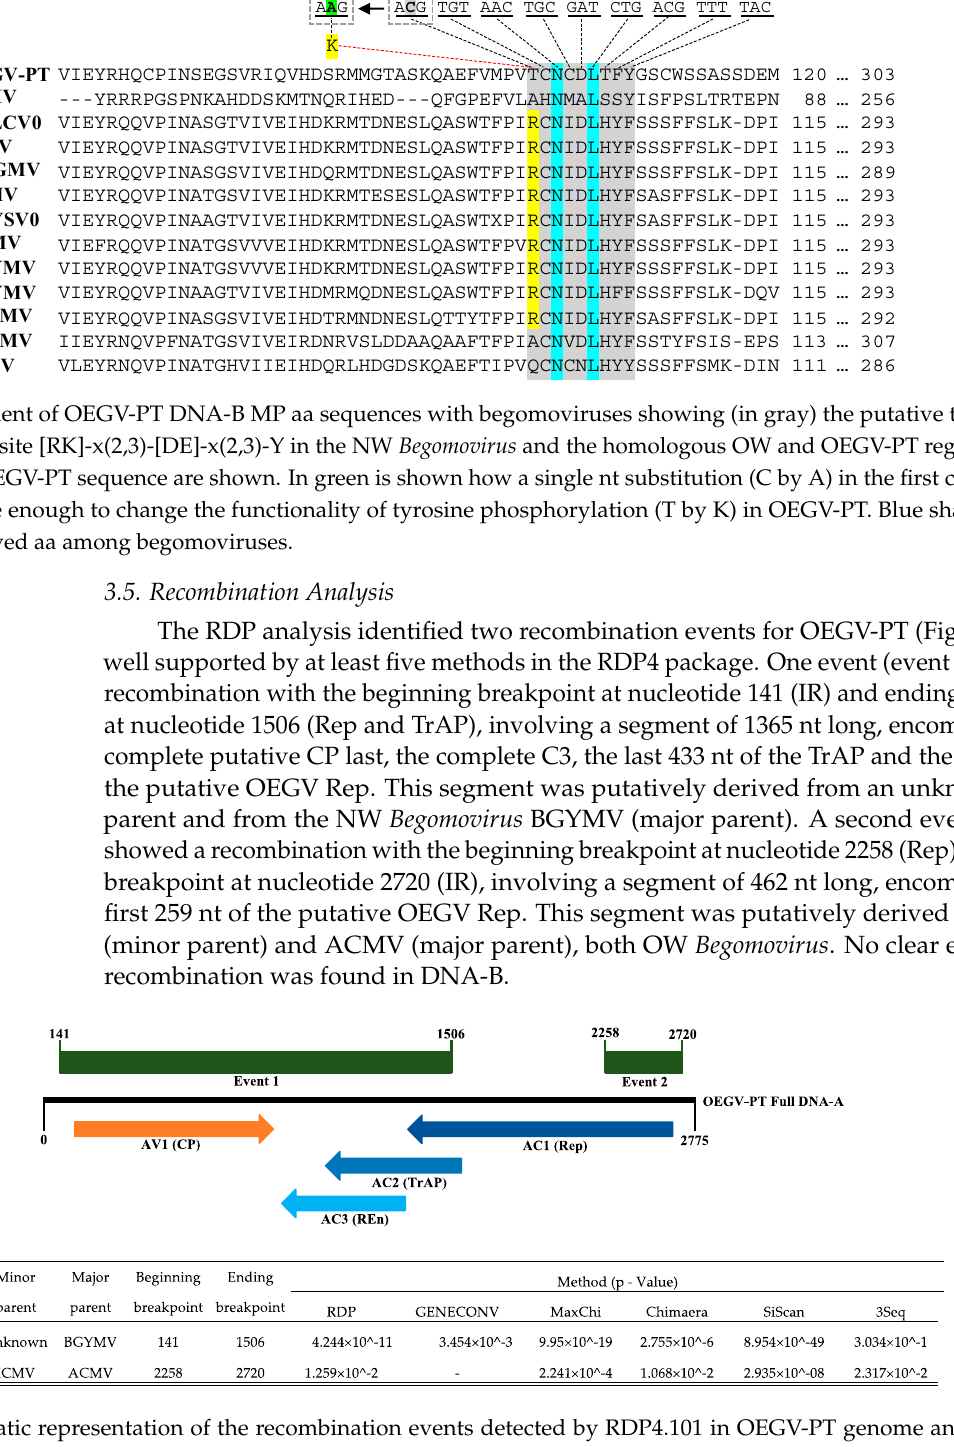
Figure 5. Schematic representation of the recombination events detected by RDP4.101 in OEGV-PT genome and corre- sponding p-values. A simplified linearized map was used to represent OEGV-PT full DNA-A. The floating boxes above the genome show the position of the two recombination events in OEGV-PT DNA-A. The floating arrows below the ge- nome correspond to the position of each of the putative OEGV genes.